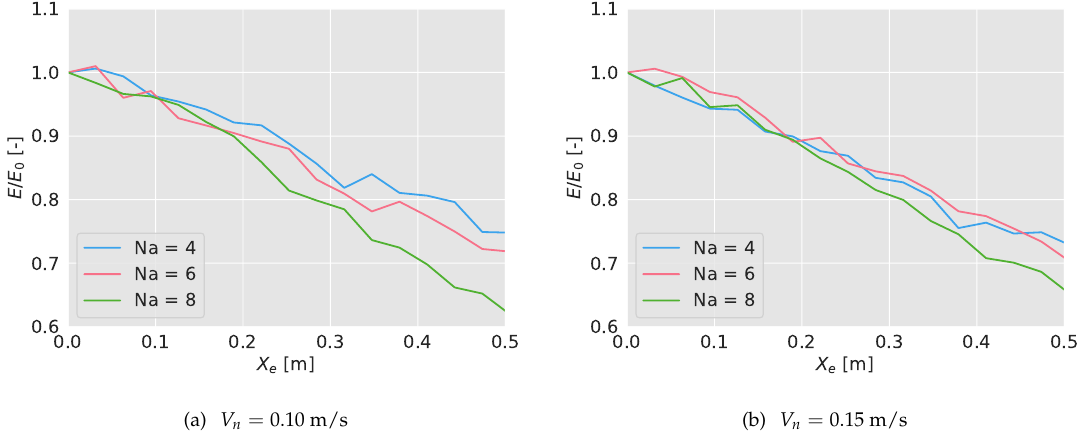
Figure 8. Efficiency of the algorithm depending on the positioning error X e , normalized with the efficiency with no error, E 0 . As the error increases, the algorithm loses